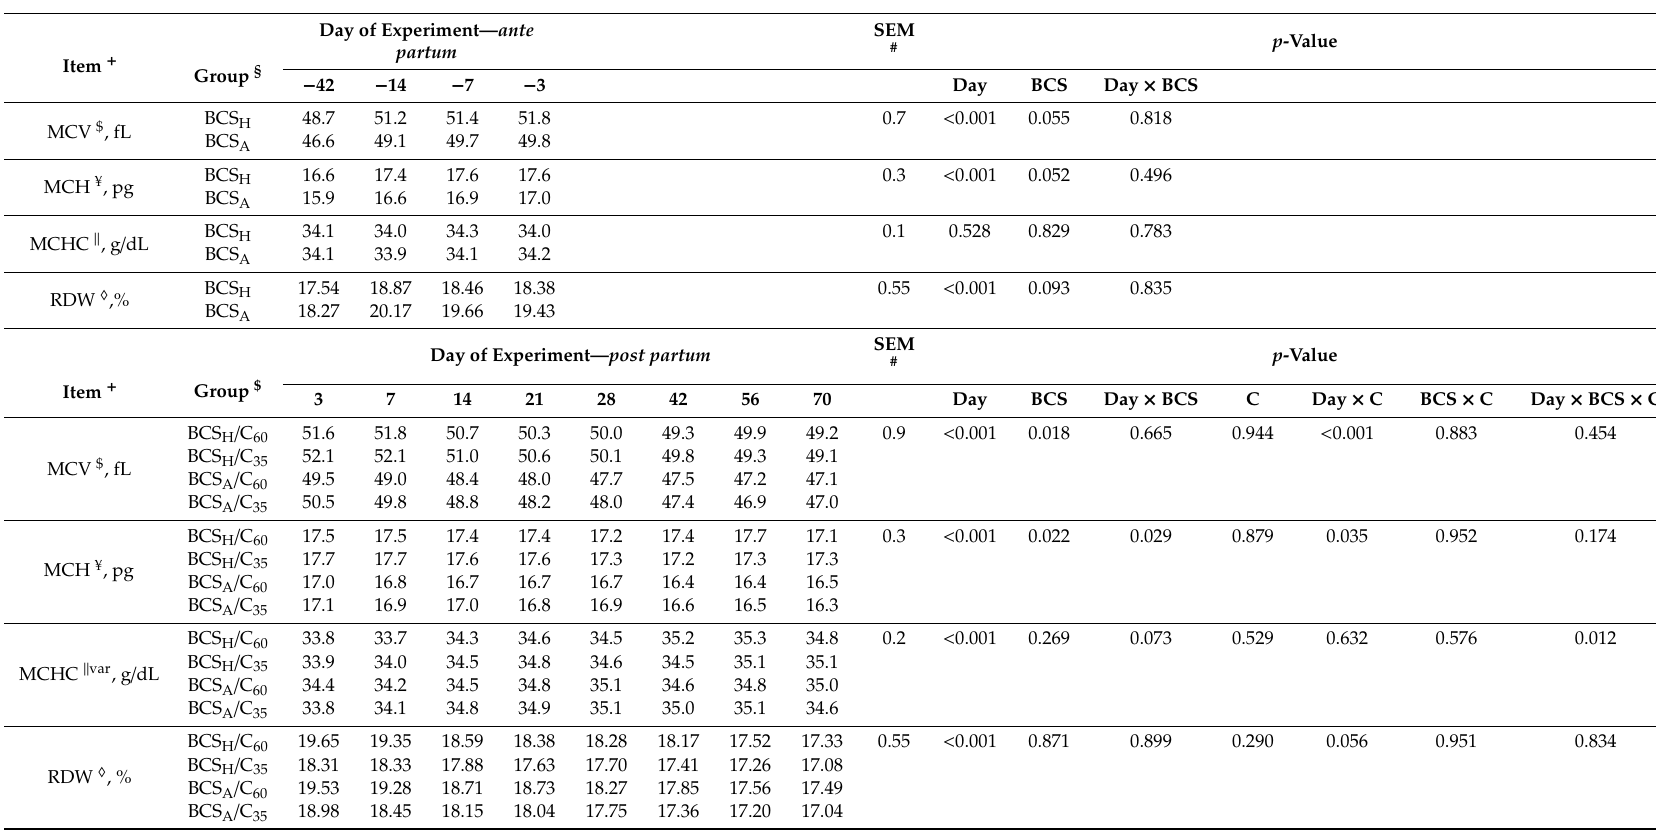
Table A2. Ante partum e ff ects of body condition score (BCS) and Days of experiment (Day), as well as post partum e ff ects of BCS, concentrate feed proportion in the diet (C) and Day on parameters of the red cell